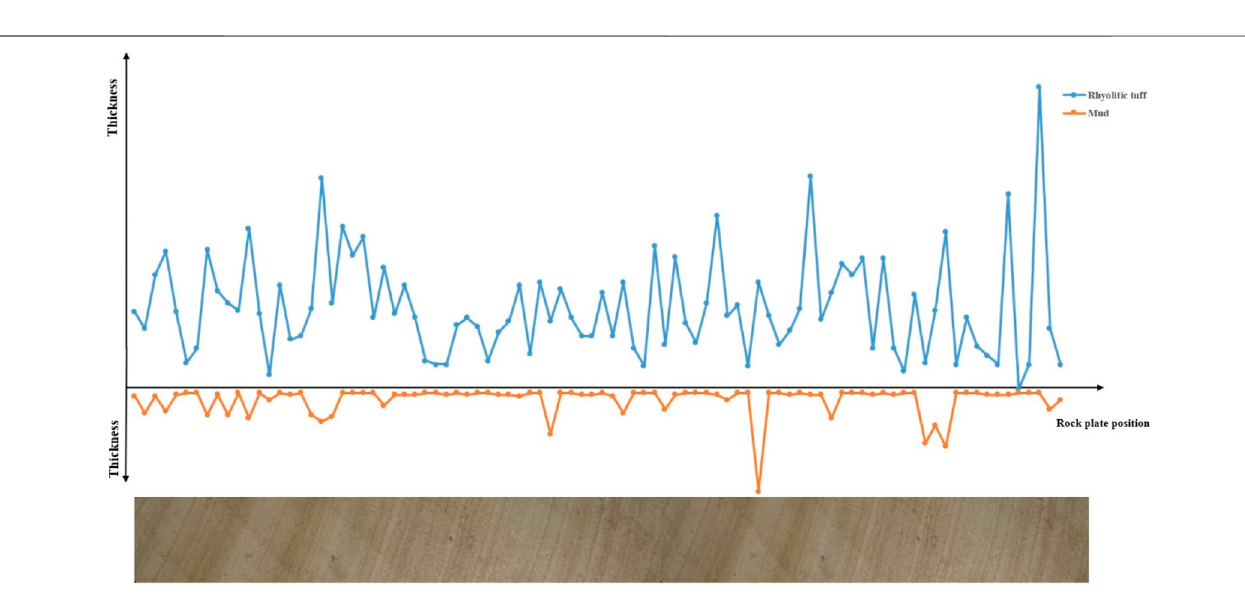
Frontiers in Earth Science |